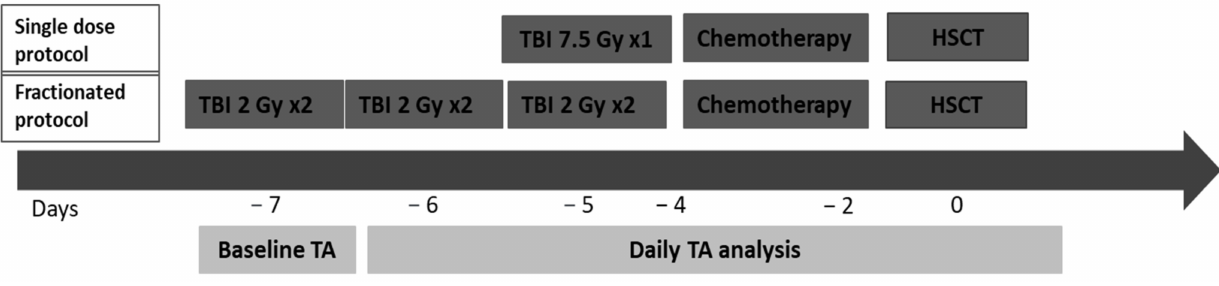
Figure 1. Timeline of total amylase (TA) evaluation. TA was analyzed at baseline, immediately before the TBI procedure, and every day until TA values normalized. Patients have received a standard dose of 12 Gy in three days delivered in six fractions or a single dose of 7.5 Gy in a single day followed by the chemotherapy part of conditioning according to the chosen